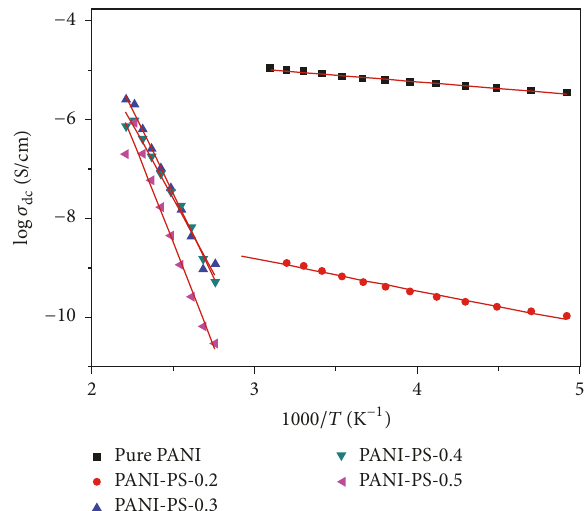
Figure 6: Temperature dependence of 𝜎 dc for the pure PANI and PANI-PS blends of different